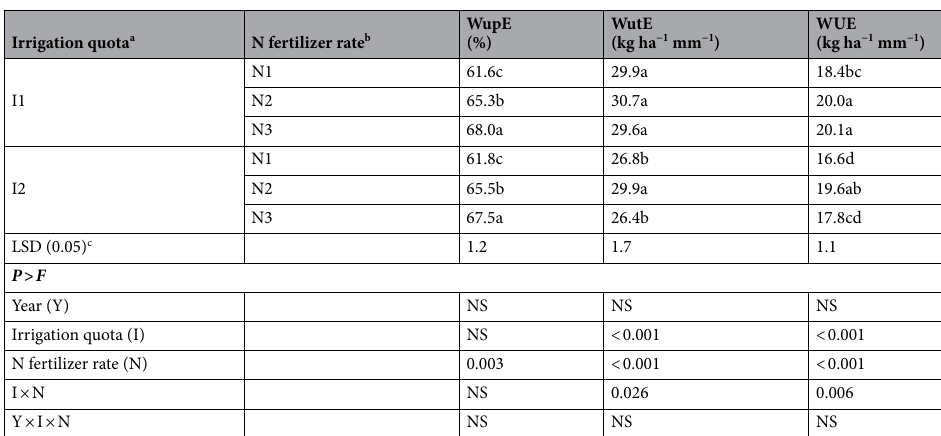
Table 3. Water uptake efficiency (WupE), water utilization efficiency (WutE), and water productivity (WUE) of spring wheat during the growing season as affected by irrigation quota and N fertilizer rate in 2016–2018. a I1 and I2 represent irrigation amount at 192 and 240 mm, respectively. b N1, N2, and N3 represent an N fertilizer rate of 135, 180, and 225 kg N ha −1 , respectively. c The LSD (0.05) and the P > F were for all the treatments in the same column, and means with different letters in the same column are significantly different at P < 0.05.